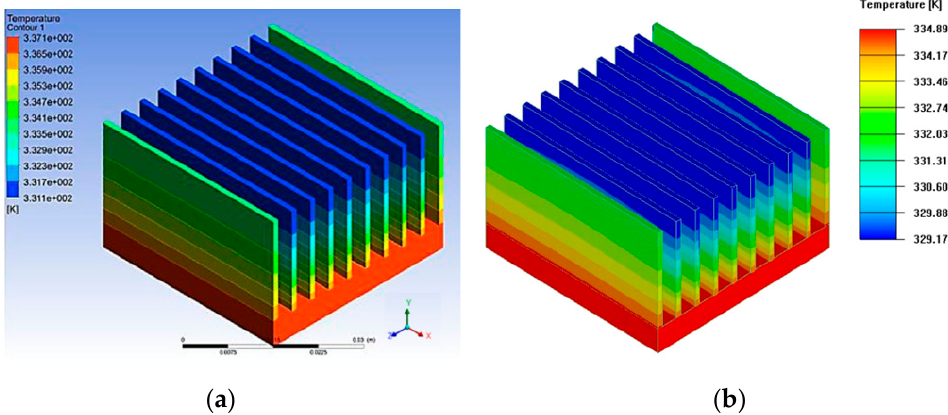
Figure 5. Validation of temperature distribution of PG heat sink at flow rate of 0.0218 kg/s (1.86 m/s). ( a ) Results obtained by Hussain et al. [34] ( b ) Results obtained using present computational model.